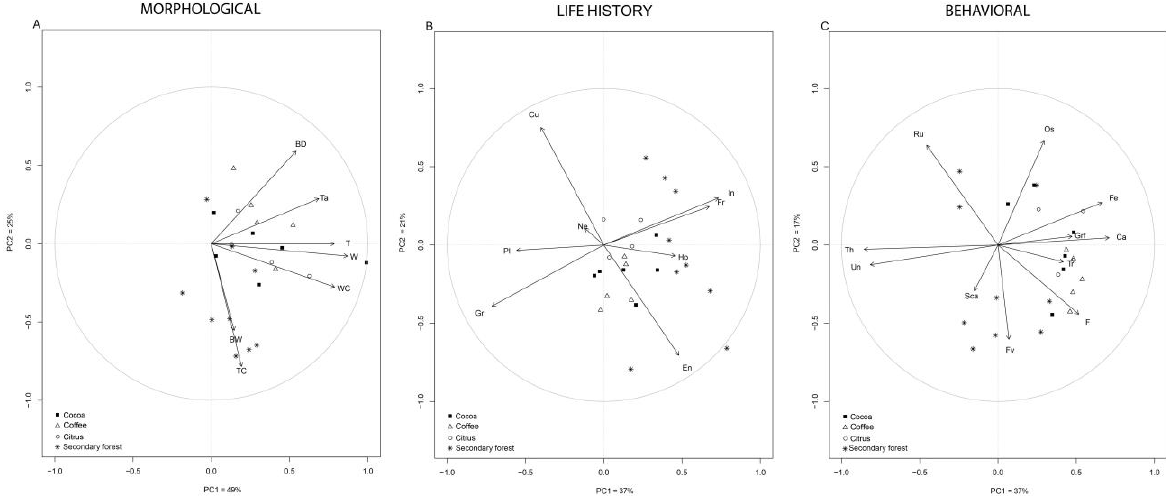
Figure 2. Relationships among functional diversity trait groups for birds in agroecosystems and secondary forests. These results are based on principal component analyses using the community weighted mean on ( A ) morphological traits, ( B ) life history traits, and ( C ) behavioral traits. Trait abbreviations are: BD: bill depth, Ta: tarsus length, T: tail length, W: weight, WC: wing chord, BW: bill width, TC: total culmination, Fr: frugivore, Gr: granivore, In: insectivorous, Ne: nectarivore, Cu: cup, En: enclosed, Ho: hole, Pl: platform, Ca: canopy, Sca: sub-canopy, Un: underbrush, Grf: ground, Fv: flower-visiting, Ru: rummage, Tr: trapper, Th: thief, F: forest, FE: forest edge, Os: open site.